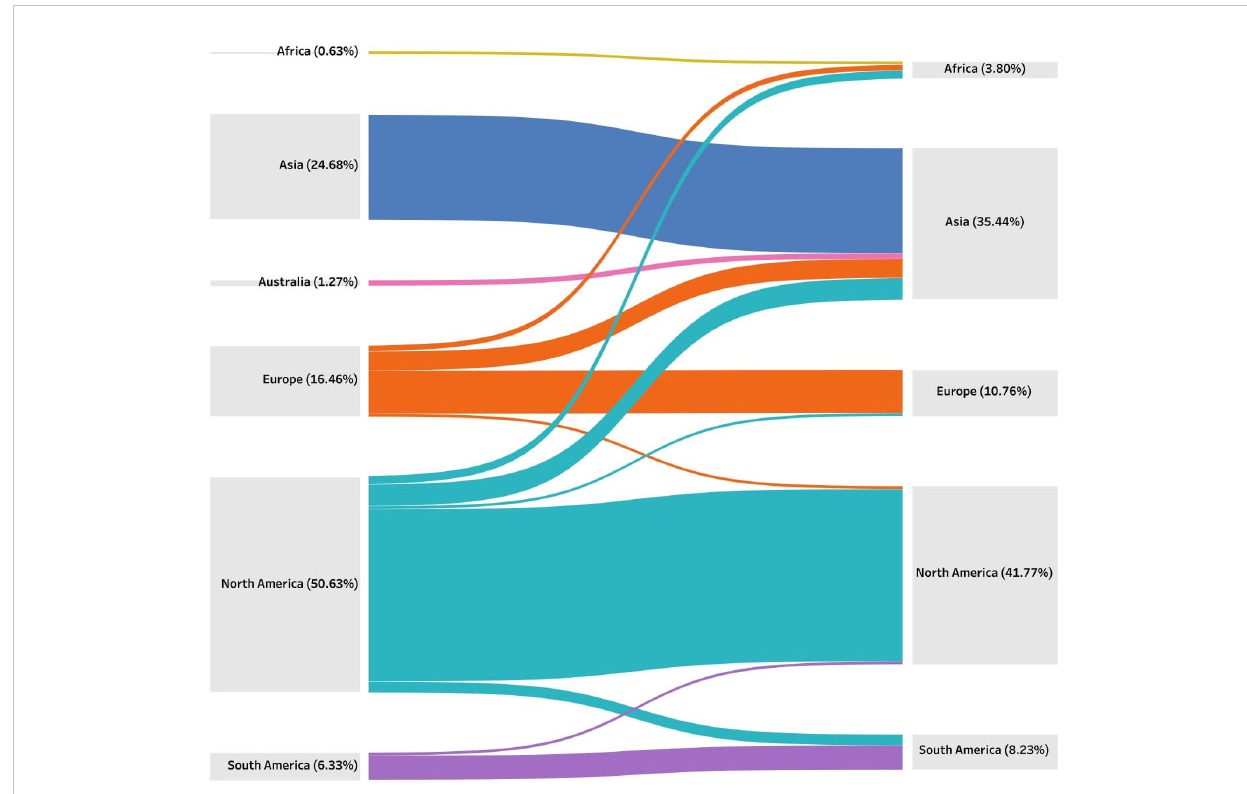
FIGURE 6 Connections between the location of the lead author ’ s institutional af fi liation and study sites/countries at a continental scale. The percentage value shows the proportion of studies for each continent where the lead author ’ s af fi liated institution was located (left) and where the study was conducted (right), and the width of the links is proportional to the number of